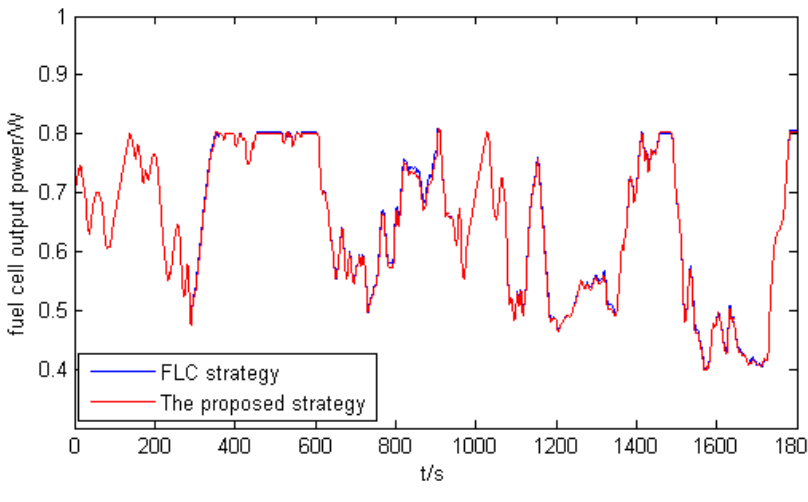
Figure 8. Variation curve of SOC .